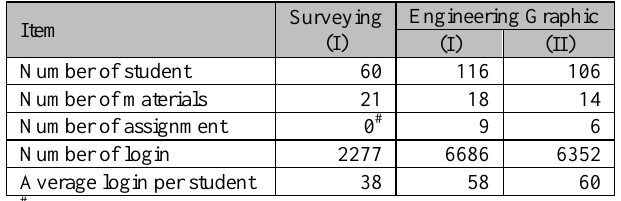
Table 1. Results of the three compulsory courses in the undergraduate program.